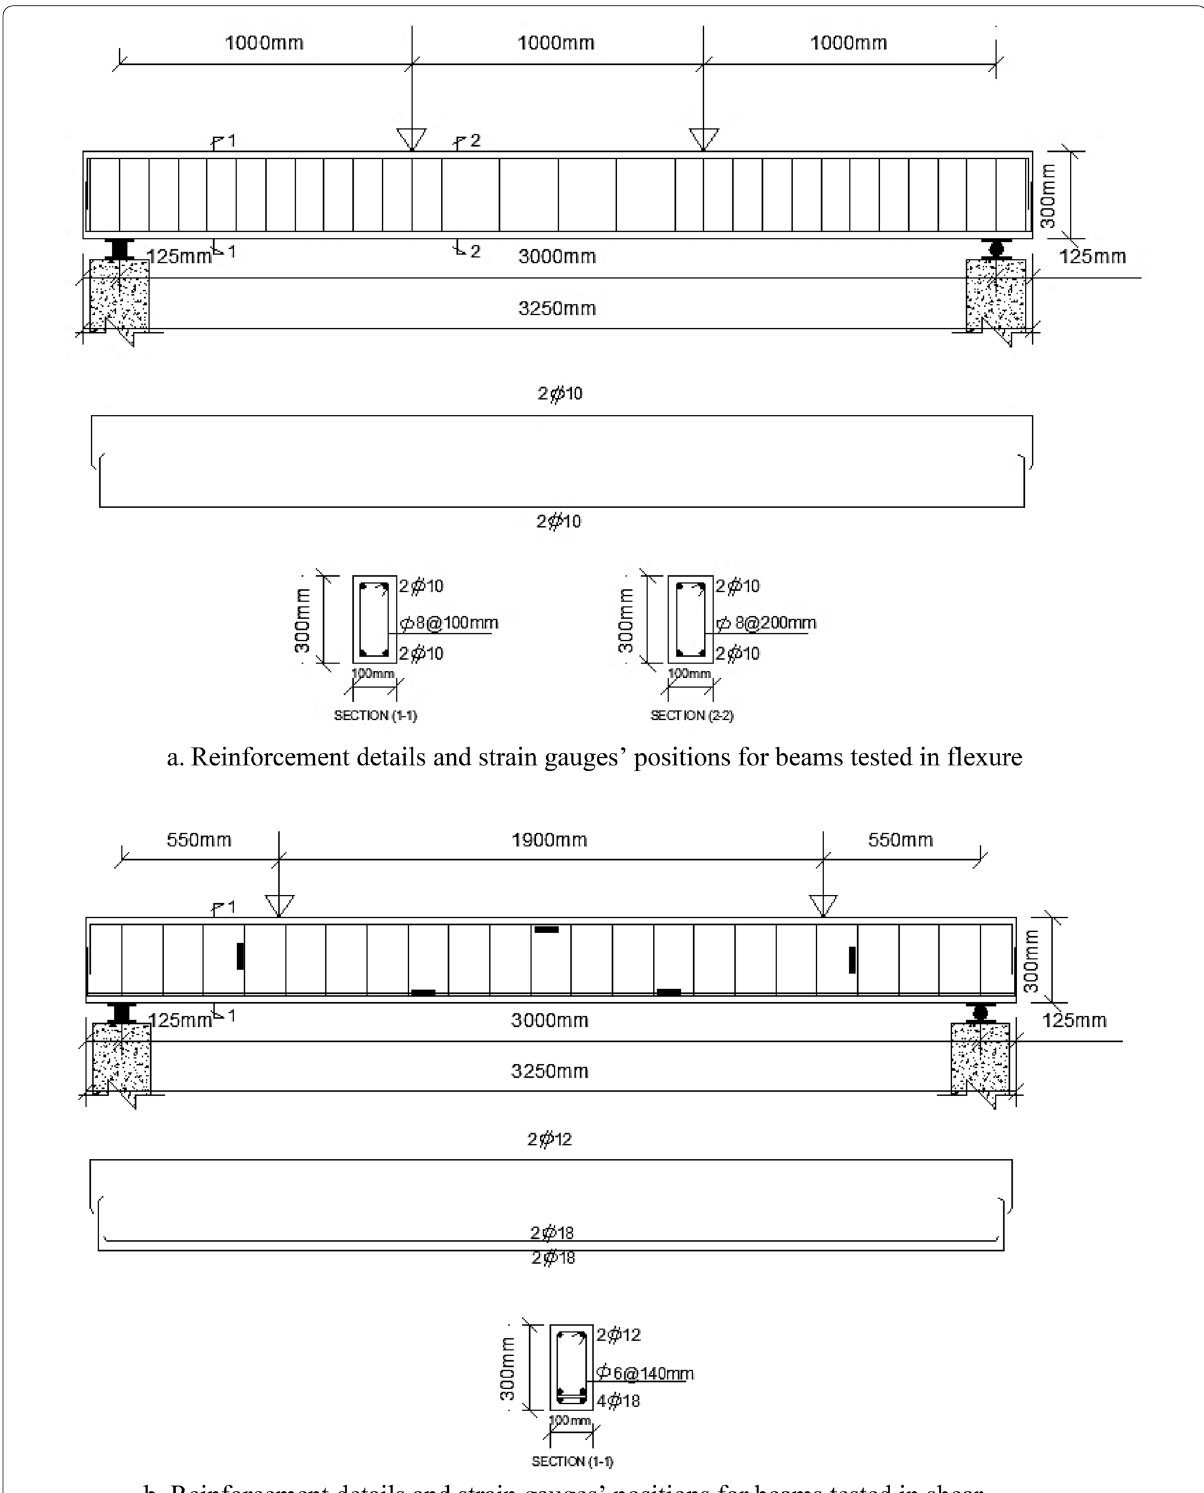
Fig. 1 Details of beam